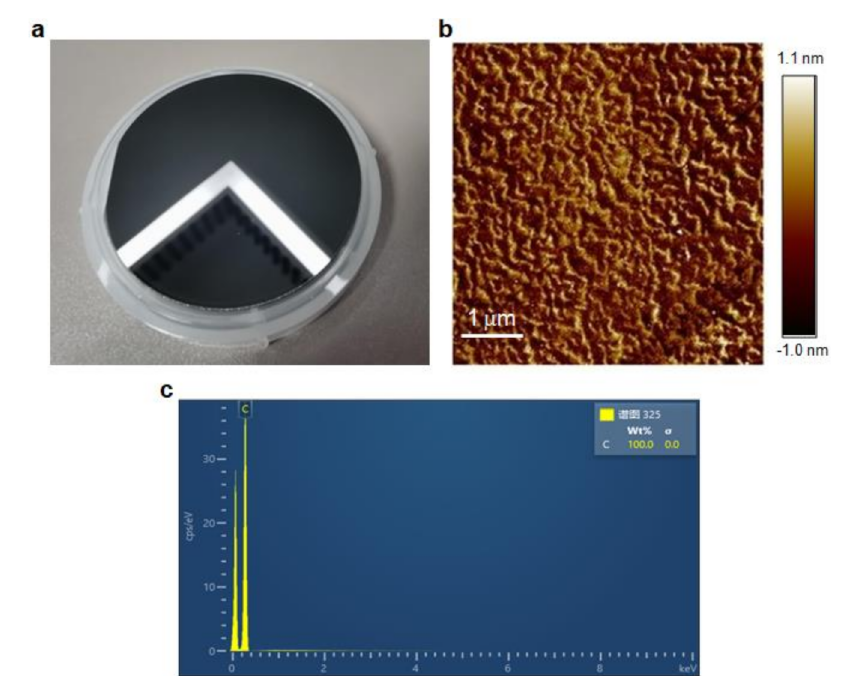
Figure 5. ( a ) 2-in polished diamond wafer (sample a); ( b ) typical AFM micrographs of film after polishing, Ra = 0.278 nm. 2-inch diamond wafer fabricated using mechanical polishing, exhibiting an ultra-smooth surface of average Ra = 0.315 nm (over the 10 scans); ( c ) EDS spectrum of the polished diamond